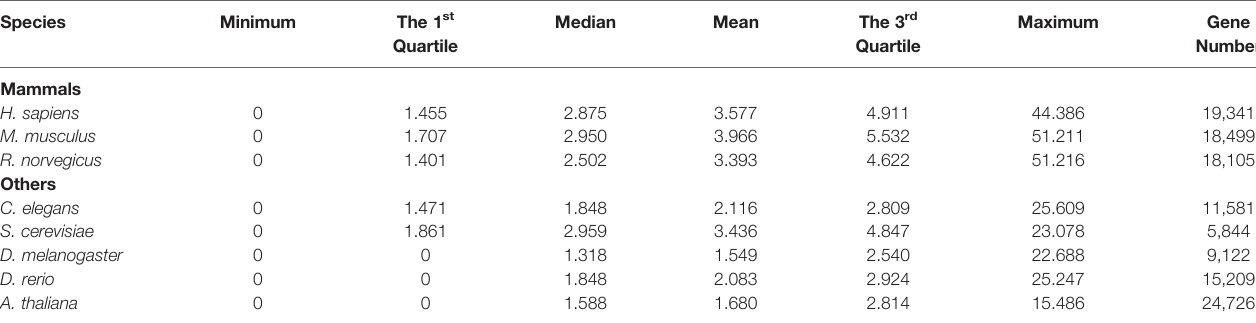
TABLE 1 | Statistical summary for SDI.